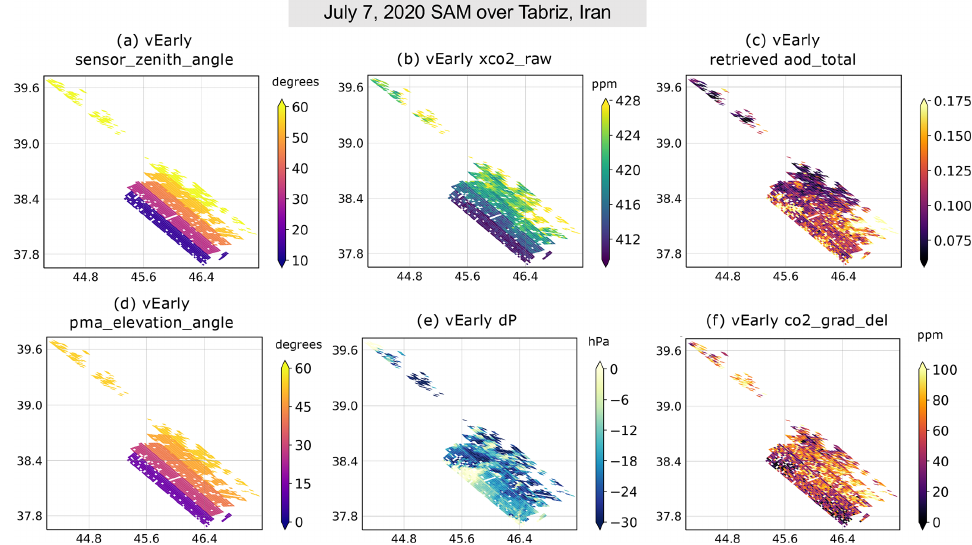
Figure 7. Maps of several retrieved and geometry-related parameters for a vEarly SAM over Tabriz, Iran, on 7 July 2020.